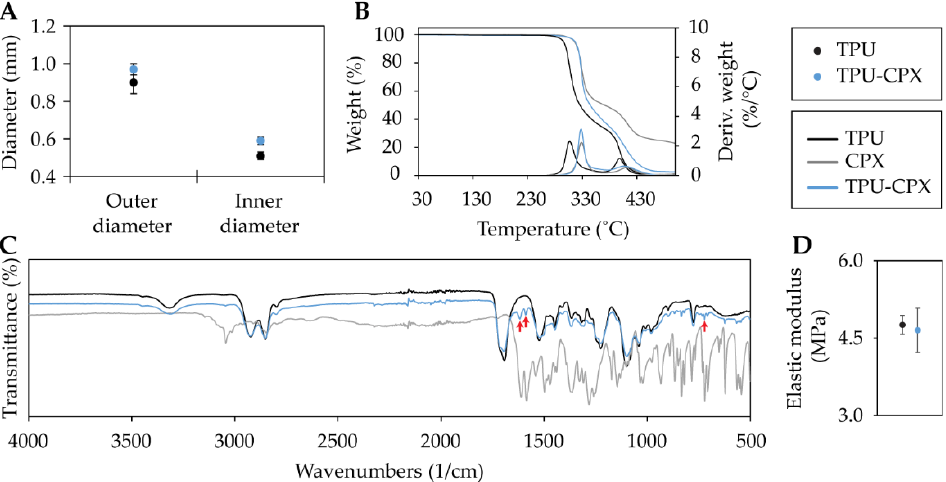
Figure 4. Outer and inner diameter of the extruded TPU and TPU-CPX tubes ( A ), thermogravimetric analysis for CPX, TPU, and TPU-CPX ( B ), FTIR spectra for CPX, TPU, and TPU-CPX, red arrows indicate CPX peaks ( C ), and tensile elastic modulus of TPU and TPU-CPX fibers ( D ). Note: in part B, Deriv. stands for derivative.